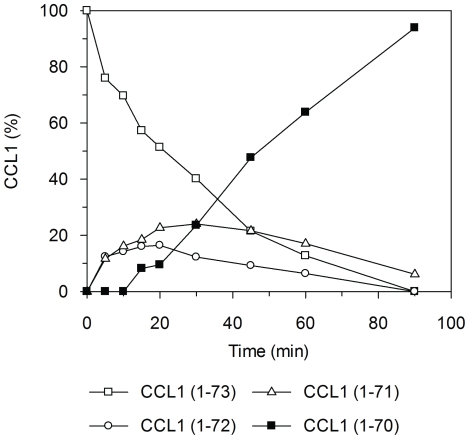
Time course of cleavage of the chemokine CCL1 by CPM.5 µM CCL1 (R & D systems) was incubated with 26 nM CPM for various time intervals. The release of the three C-terminal basic amino acids –Lys71-Arg72-Lys73 was monitored by mass spectrometry. The percentage of CCL1 variant [CCL1 (%)] is plotted against time (min). CCL1 (1–73) (□), CCL1 (1–72) (○), CCL1 (1–71) (▵) and CCL1 (1–70) (▪).